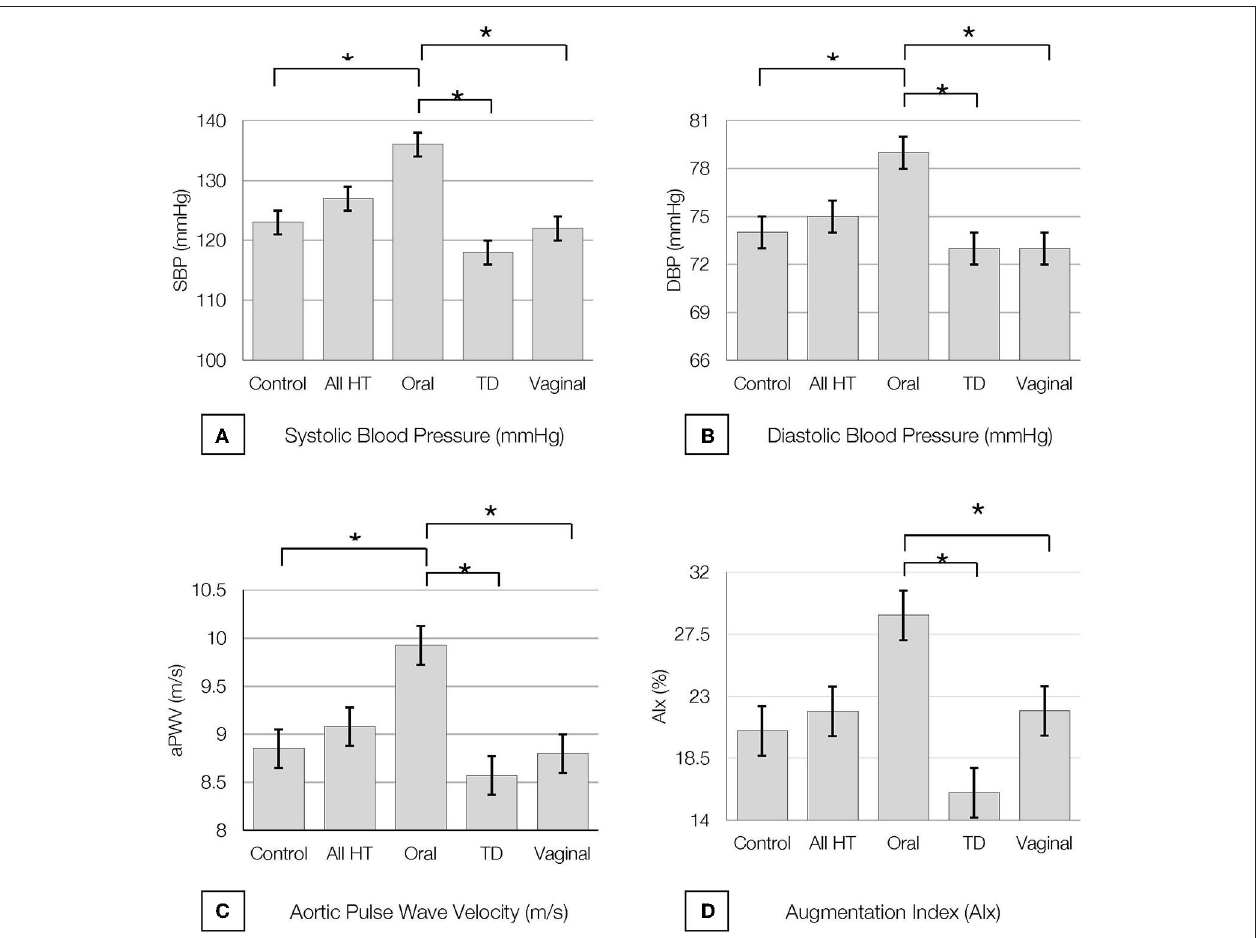
FIGURE 2 | Baseline (A) Systolic Blood Pressure (SBP), (B) Diastolic Blood Pressure (DBP), (C) Pulse Wave Velocity (PWV) and (D) Augmentation Index at 75 bpm (AI@75) by hormone therapy type. All values are presented as mean ± SE.* indicates P < 0.05. All HT, all hormone therapy users; TD, transdermal.